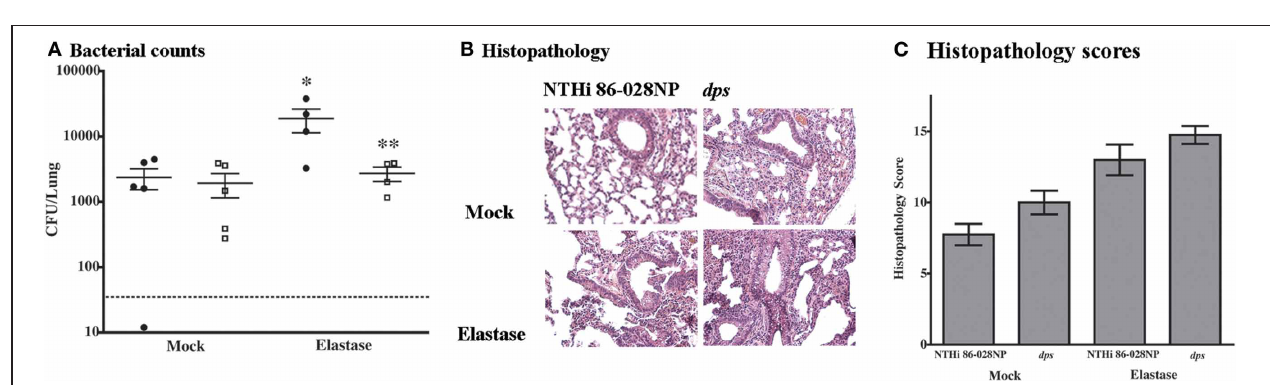
(B) Histopathologic sections from infected lung tissue. Sections were prepared as described previously (Pang et al., 2008a,b) and stained with hematoxylin/eosin according to standard methodology. (C) Inflammatory scores for sections from infected mice. All sections were graded as a blinded set for markers of inflammation as described previously (Pang et al., 2008a,b). Statistical significance was determined by t -test as